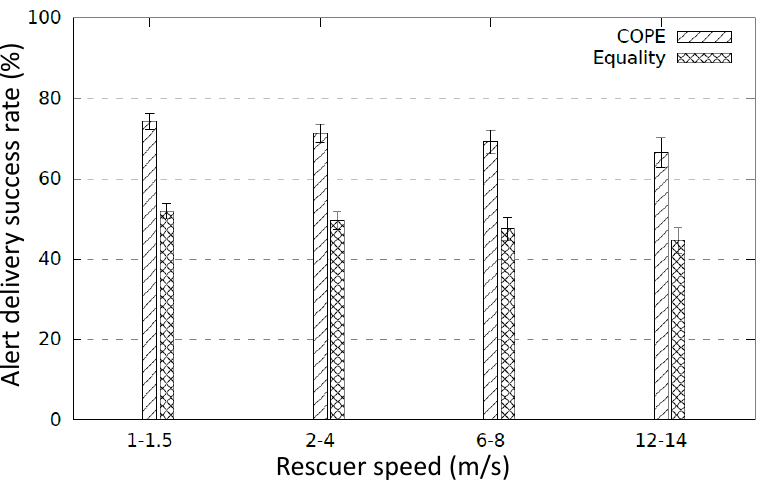
Figure 13. Alert delivery success rate where some nodes are still